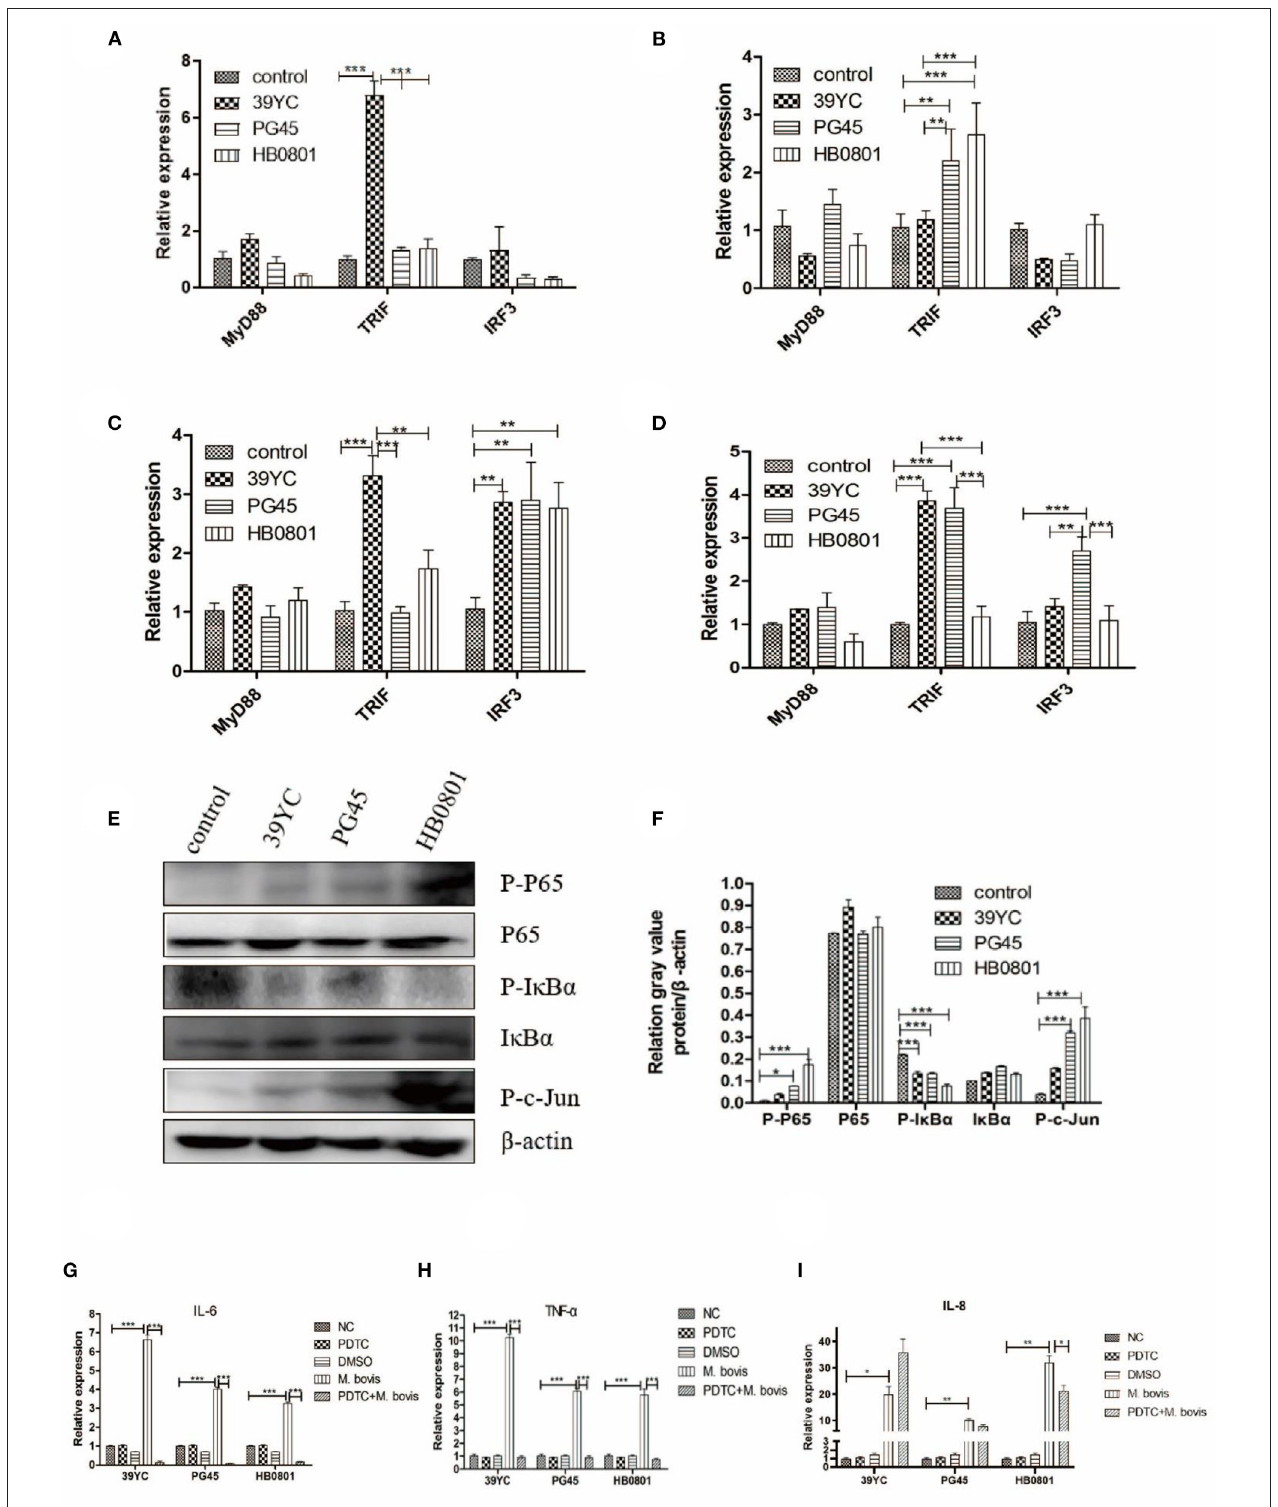
FIGURE 5 | Changes of inflammatory signaling pathways in BMECs induced by M. bovis. (A–D) Related factors expression of BMECs infected with M. bovis at different time points, (A) 10h post-infection (hpi), (B) 16 hpi, (C) 20 hpi, (D) 24 hpi. Proteins expression of TLRs from BMECs infected by M. bovis , (E) Western Blot, (F) gray value analysis. Expression of IL-6, TNF- α , and IL-8 after BMECs infected by M. bovis and NF- κ B inhibited by PDTC of qRT-PCR, (G) IL-6, (H) TNF- α , (I) IL-8. * p < 0.05, ** p < 0.01, and *** p < 0.001.